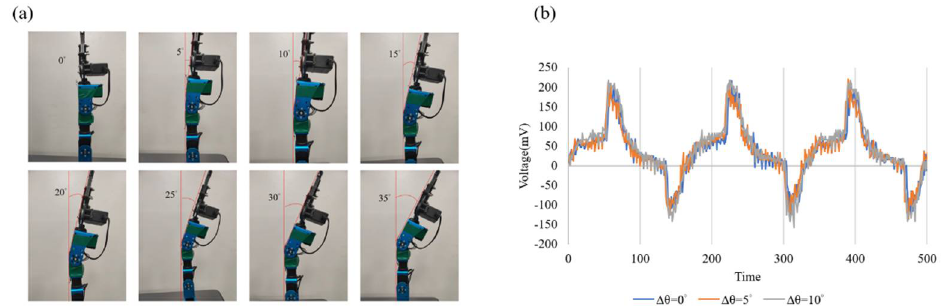
Figure 10. ( a ) Bending diagram of robotic arms from 0 to 35°; ( b ) Piezoelectric effects at bending angles of 0, 5, and 10°.